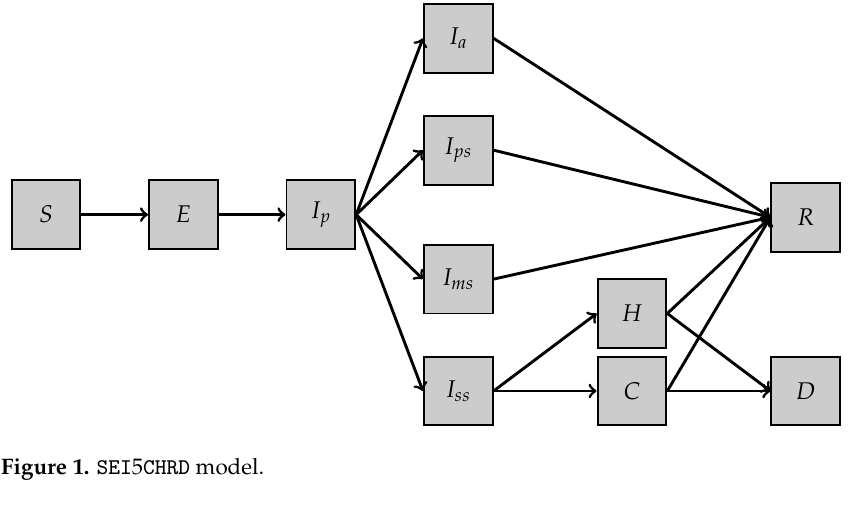
Figure 1. SEI 5 CHRD model